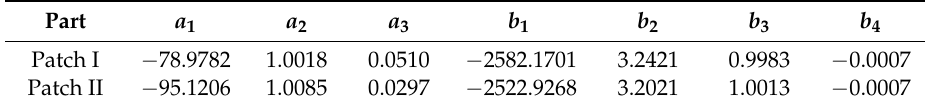
Figure 8. SIFT matching of the image patches using texture: ( a ) image clipping above the strip and ( b ) image clipping below the strip. Their respective 3D reconstructions are presented in ( c , d ). Table 3. Parameters of the geometric transformation estimated by least squares adjustment in two image